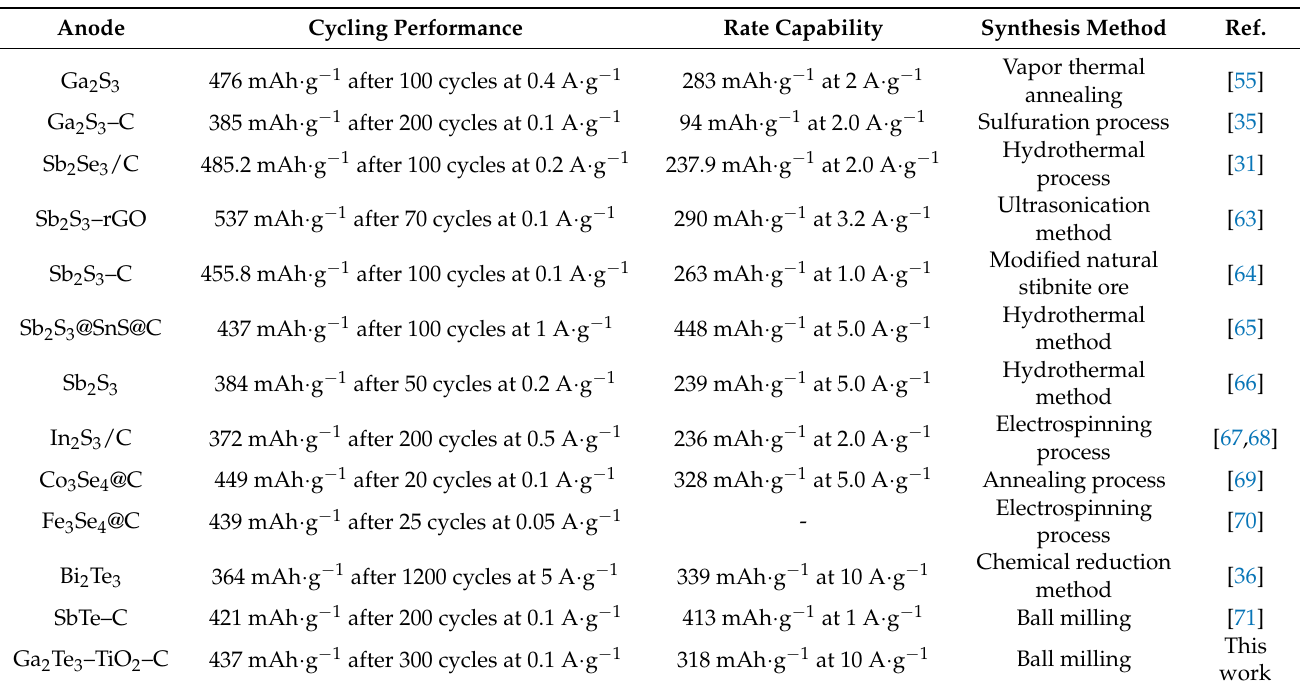
Table 1. Comparison of performances of chalcogenide-based anodes for SIBs.